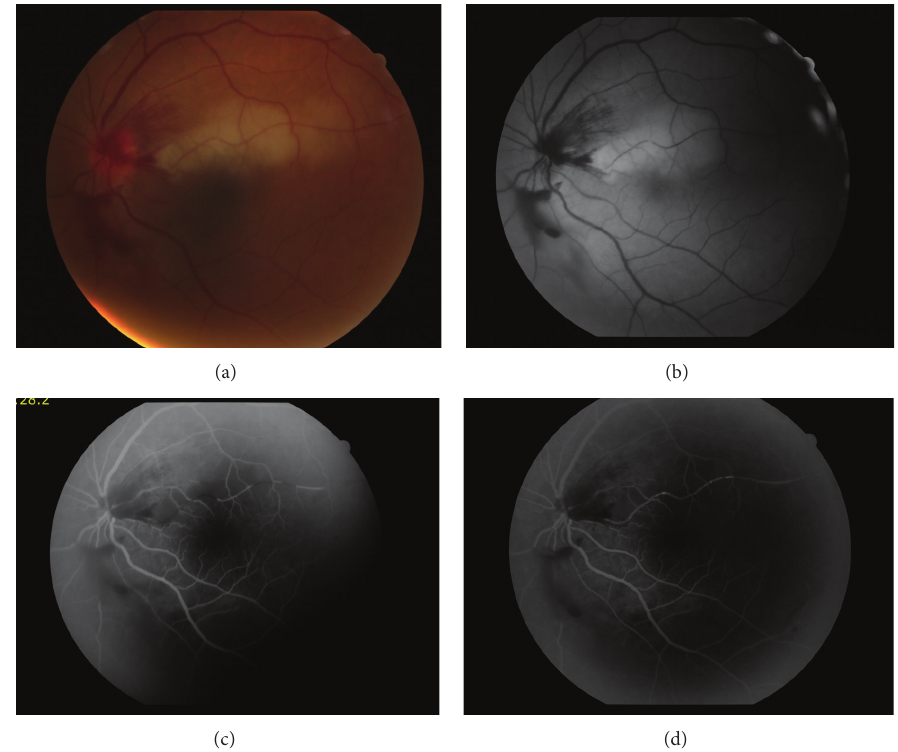
Figure 1: (a and b) Color and red free fundus photograph of the left eye representing peripapillary flame-shaped hemorrhages and pale retina in the upper temporal arcuate. (c and d) Fundus fluorescein angiography showed filling defects in the upper temporal branch retinal artery in the early phase. There were also multiple embolic opacities along the